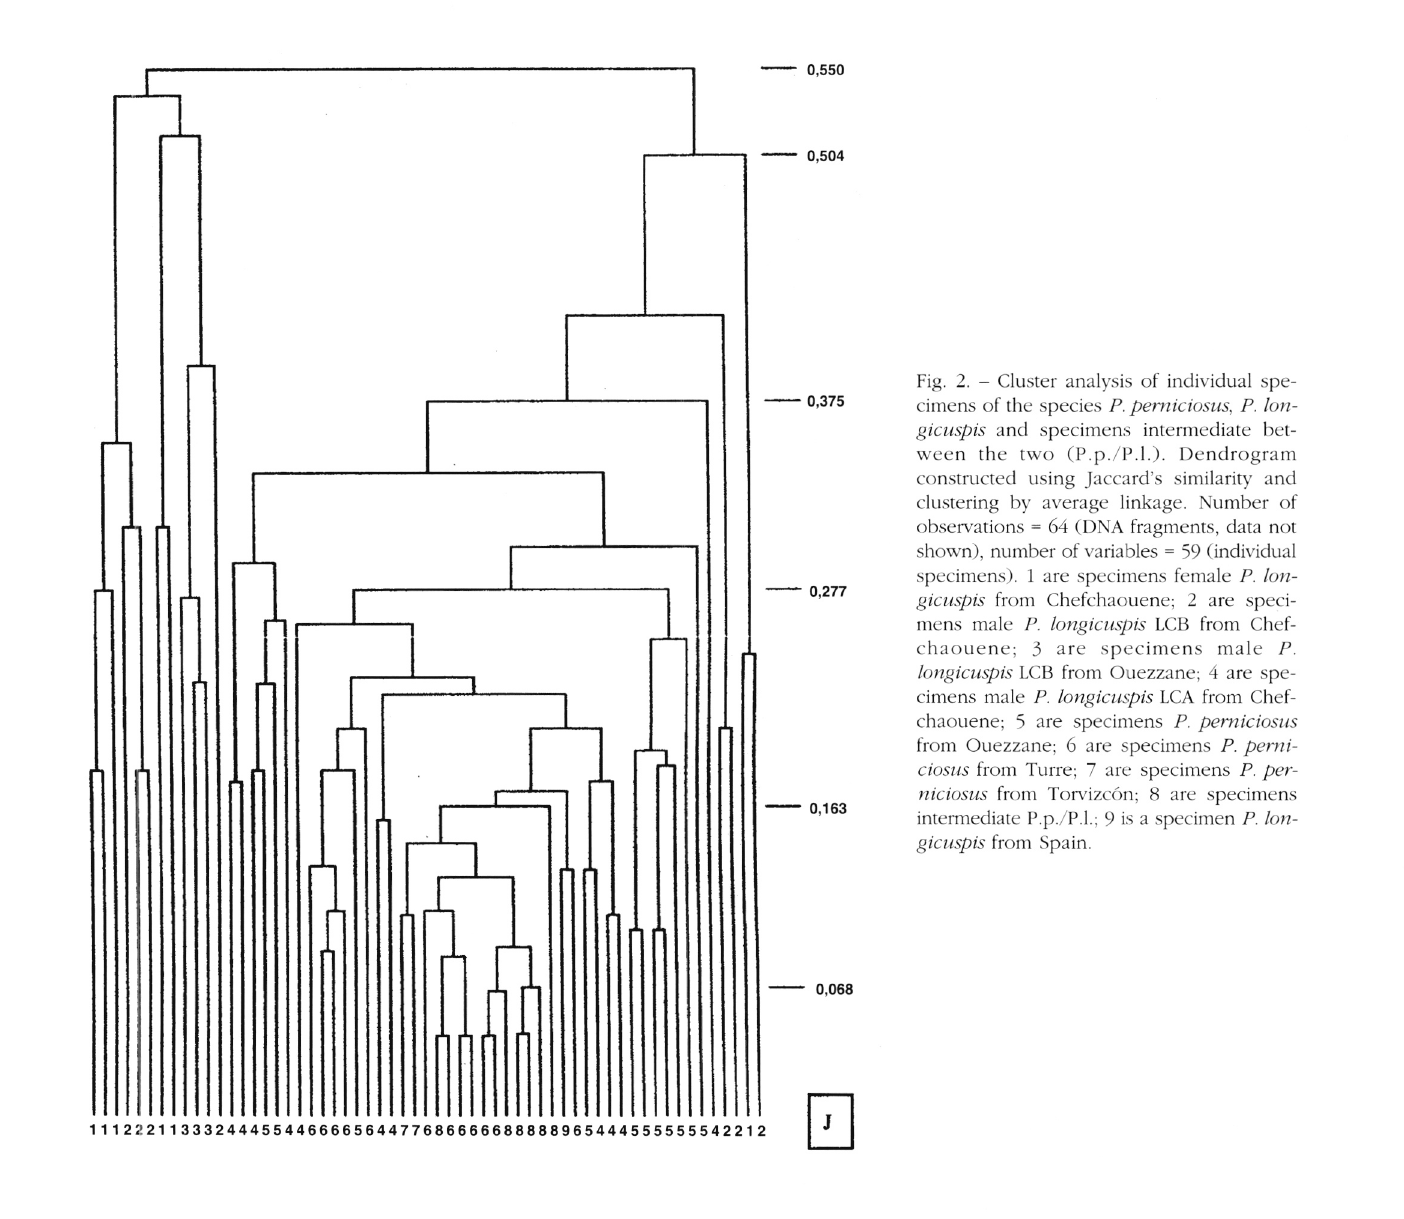
Fig. 2. - Cluster analysis of individual spe­ cimens of the species P. perniciosus, P. lon- gicuspis and specimens intermediate bet­ ween the two (P.p./P.l.). Dendrogram constructed using Jaccard’s similarity and clustering by average linkage. Number of observations = 64 (DNA fragments, data not shown), number of variables = 59 (individual specimens). 1 are specimens female P. lon- gicuspis from Chefchaouene; 2 are